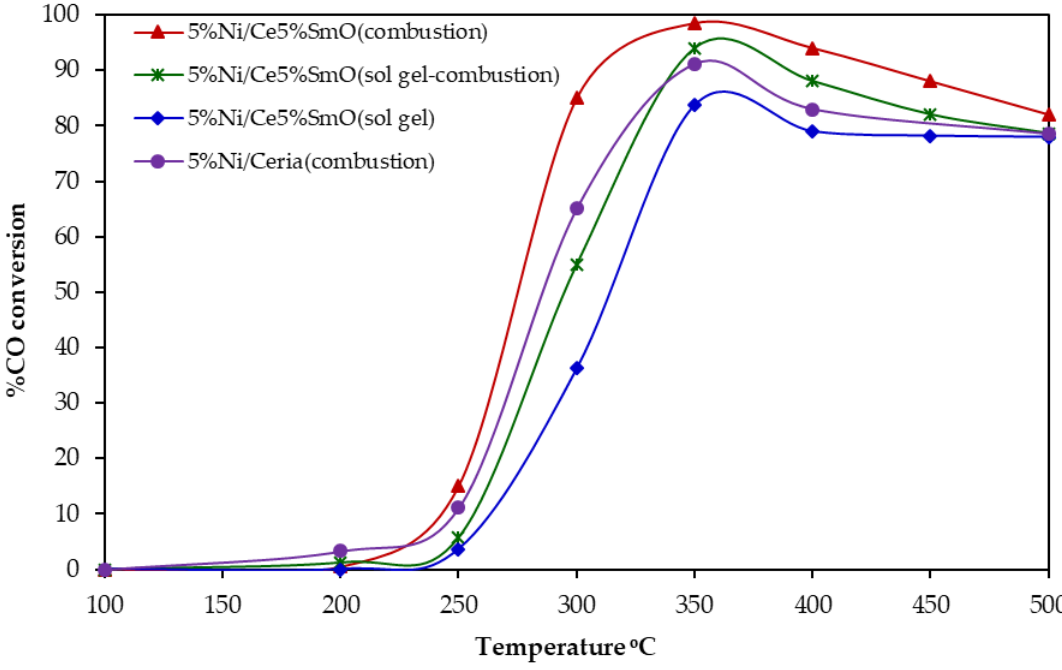
Figure 5. Water gas shift activity of supported Ni catalysts.